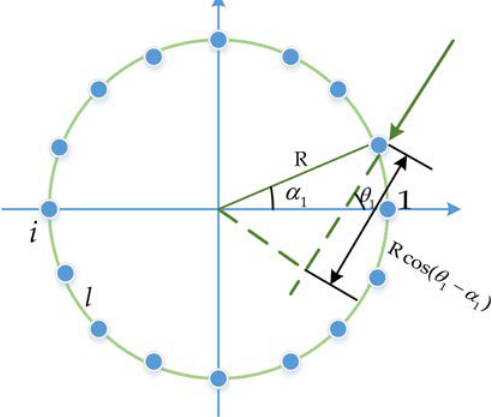
Figure 4. Uniform circular array.